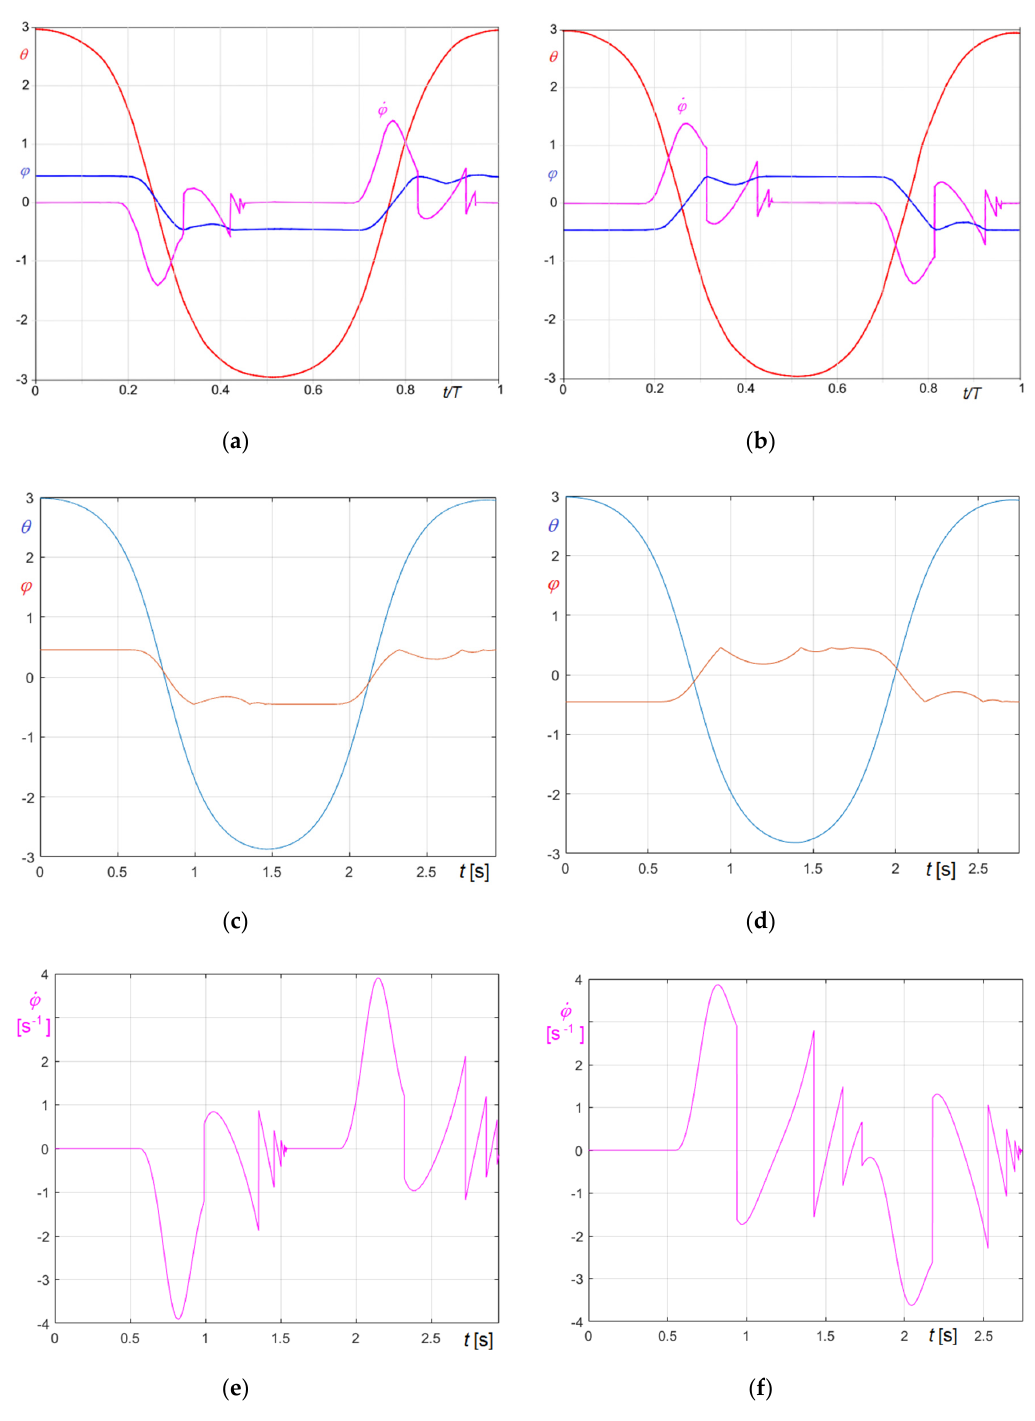
Figure 7. First cycle of bell oscillations and clapper strikes for bell 1: ( a ) Reference results for bell ringing right (adapted from [18]); ( b ) Reference results for bell ringing wrong (adapted from [18]); ( c ) Bell ringing right: θ = θ ( t ) and ϕ = ϕ ( t ) curves obtained with the proposed algorithm; ( d ) Bell ringing wrong: θ = θ ( t ) and ϕ = ϕ ( t ) curves obtained with the proposed algorithm; ( e ) Bell ringing right: (cid:2030)(cid:4662) = (cid:2030)(cid:4662)(cid:4666)(cid:1872)(cid:4667) curve obtained with the proposed algorithm; ( f ) Bell ringing wrong: (cid:2030)(cid:4662) = (cid:2030)(cid:4662)(cid:4666)(cid:1872)(cid:4667) curve obtained with the proposed algorithm.